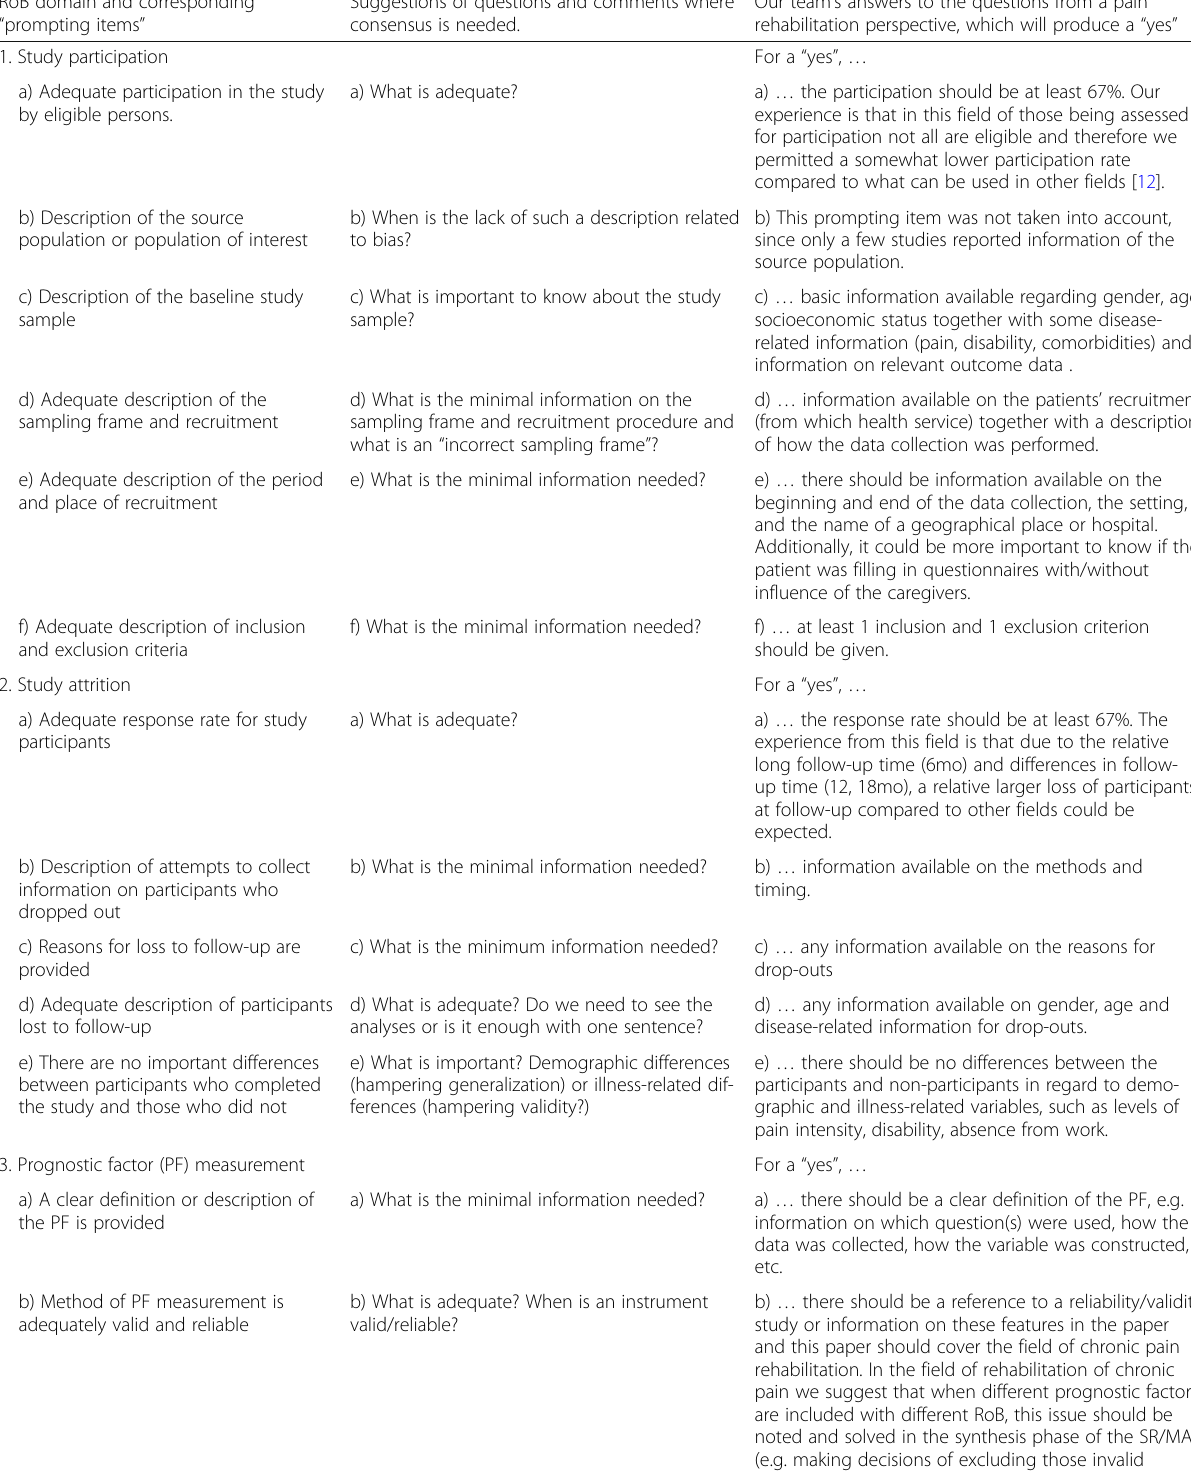
Table 3 Suggestions for questions and comments on QUIPS risk of bias domains and our team ’ s proposed answers RoB domain and corresponding “ prompting items